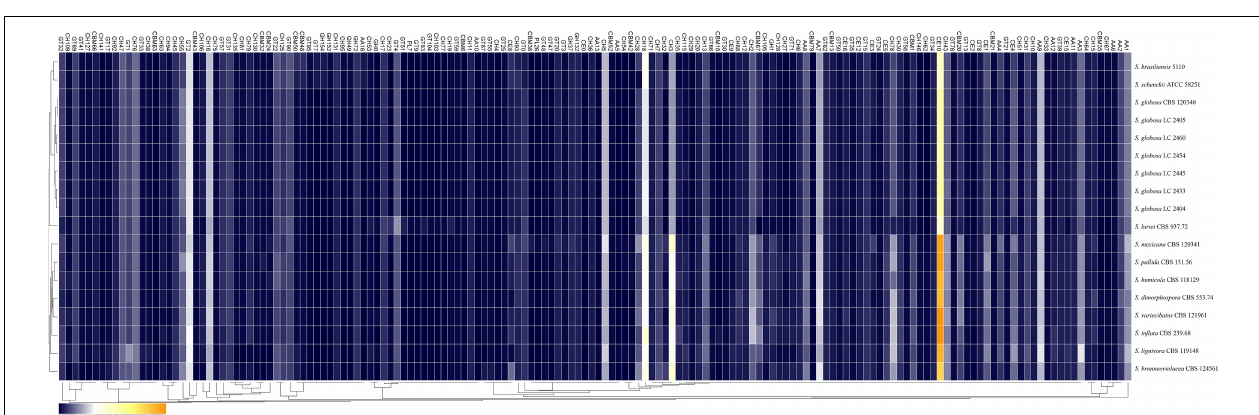
FIGURE 3 | Gene contraction of carbohydrate-active enzymes (CAZymes) in the genus Sporothrix. Genes of Sporothrix identified through CAZy database were classified into 6 categories. CAZymes genes of the four main clinical species ( S. brasiliensis , S. schenckii , S. globosa, and S. luriei ) were significantly less than those of the other Sporothrix species, especially the genes belonging to the GH and CE groups.